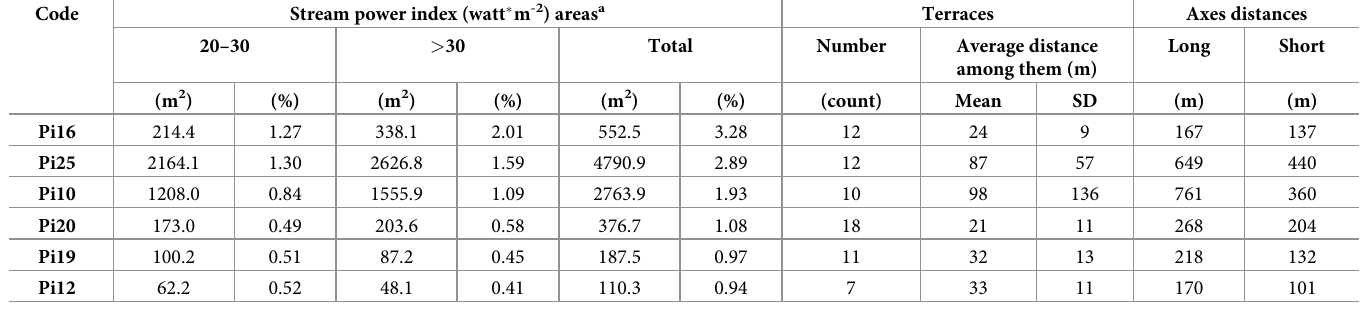
Fig 8. Elevation profiles derived for the ellipsoid axes of the prioritized Pucaras . Dotted lines indicate the position of terraces. https://doi.org/10.1371/journal.pone.0281869.g008 Table 8. Summary of erosion-prone areas identified with stream power index, together with terraces number and their ellipsoid axes distances for the prioritized Pucaras